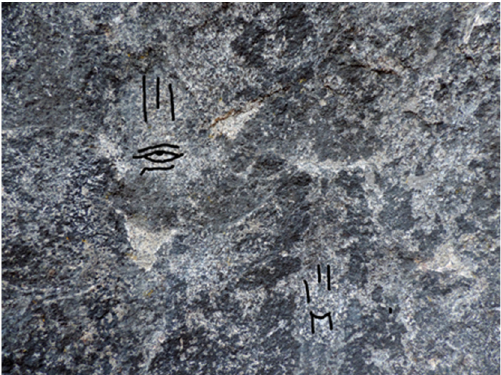
Figure 38. Truckee CA, locus 2 (enhanced with drawing on the print to make the design elements more visible).